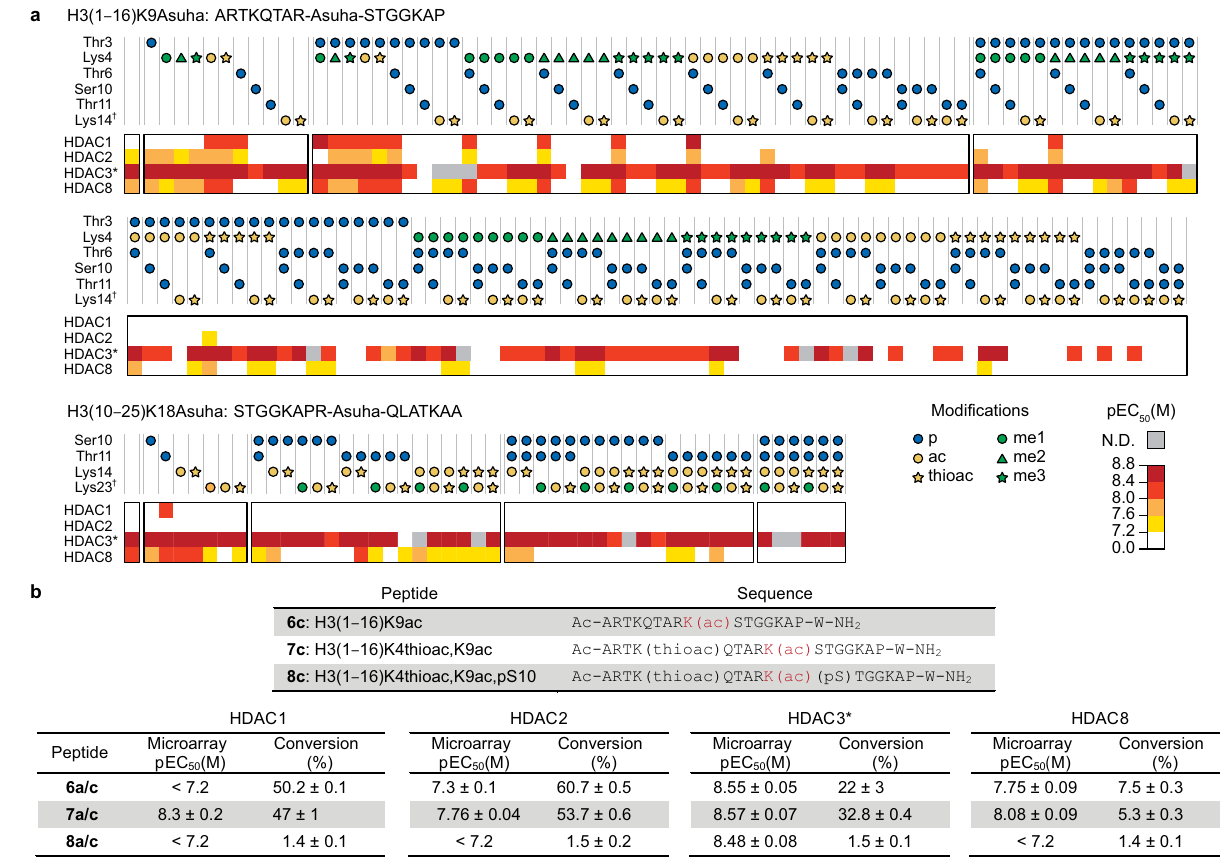
Fig. 5 Deciphering the regulation of HDAC action by histone PTMs. a Heat map depicting effects of neighboring chemical modi fi cations on the af fi nity of peptides H3(1 ‒ 16)K9Asuha and H3(10 ‒ 25)K18Asuha. p: phosphorylation, ac: acetylation, thioac: thioacetylation, me1: monomethylation, me2: demethylation, me3: trimethylation. Combinations of 4, 5, and 6 modi fi cations abolished binding to H3(1 ‒ 16)K9Asuha peptides and have not been included. The pEC 50 values represent the concentration of HDAC enzyme required for half-maximal binding signal, n = 4 independent experiments). White squares represent weak binders (pEC 50 < 7.2). Source data are provided as a Source Data fi le. b Resynthesized peptide sequences with Kac at the position of study, and relative deacetylation by class I HDACs. Enzyme and substrate were incubated for 1 h at 37 °C, and relative conversion was determined by LCMS (see Supplementary Fig. 9 for sample assay traces). Microarray data represent mean ± SEM, n = 4 indepe n dent experiments; conversion data represent mean ± SD, n ≥ 2 indepe n dent experiments. *HDAC3 tested in combination with the DAD domain of NCoR2. † Matrix steric effects might contribute to the effects at these